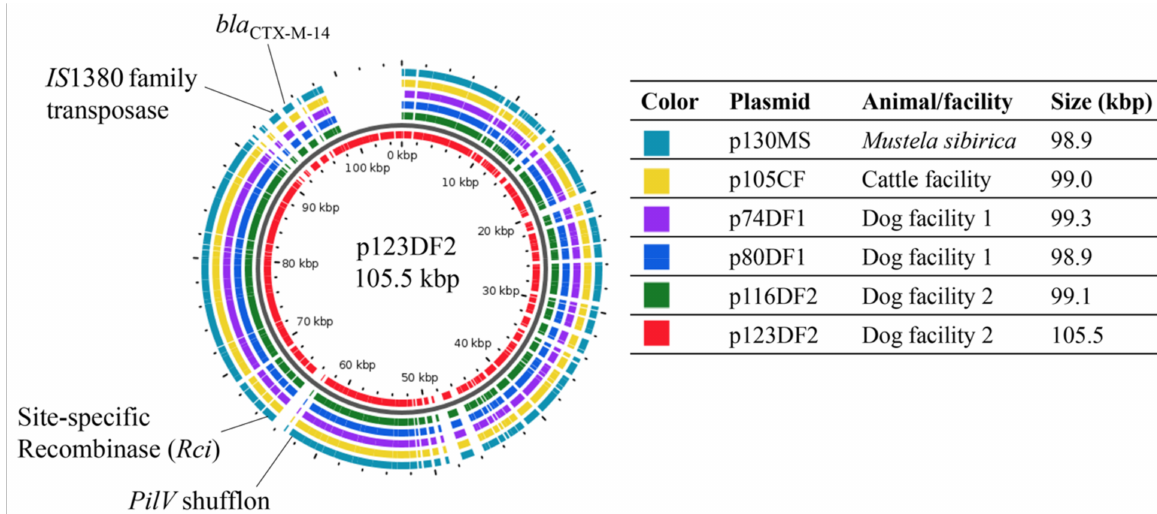
Figure 3. Physical mapping composition of the sequences of six CTX-M-14 plasmids by BLAST Atlas analysis using p130MS, p105CF, p74DF1, p80DF1, and p116DF2 as query sequences against the longest CTX-M-14 plasmid (p123DF2) as reference sequence. Nucleotide sequences were highly similar among the six plasmids, though p123DF1 had an insertion site. This figure was constructed using the GView Server after performing BLAST Atlas